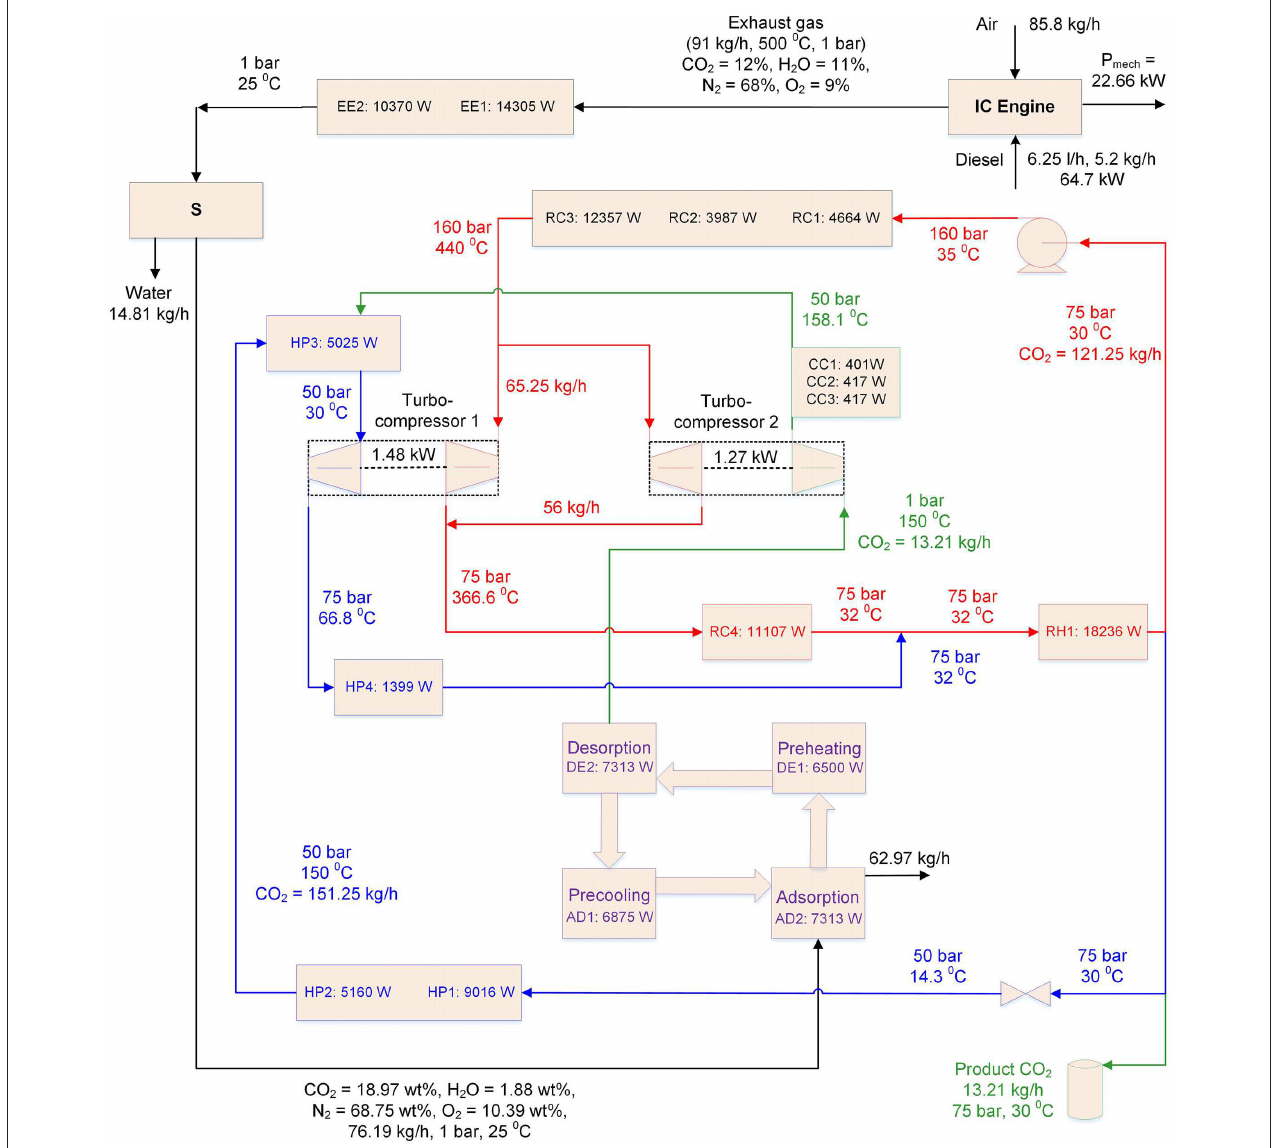
FIGURE 9 | Heat and mass flow details of design of CO 2 capture system (1h operation or 6.25l diesel